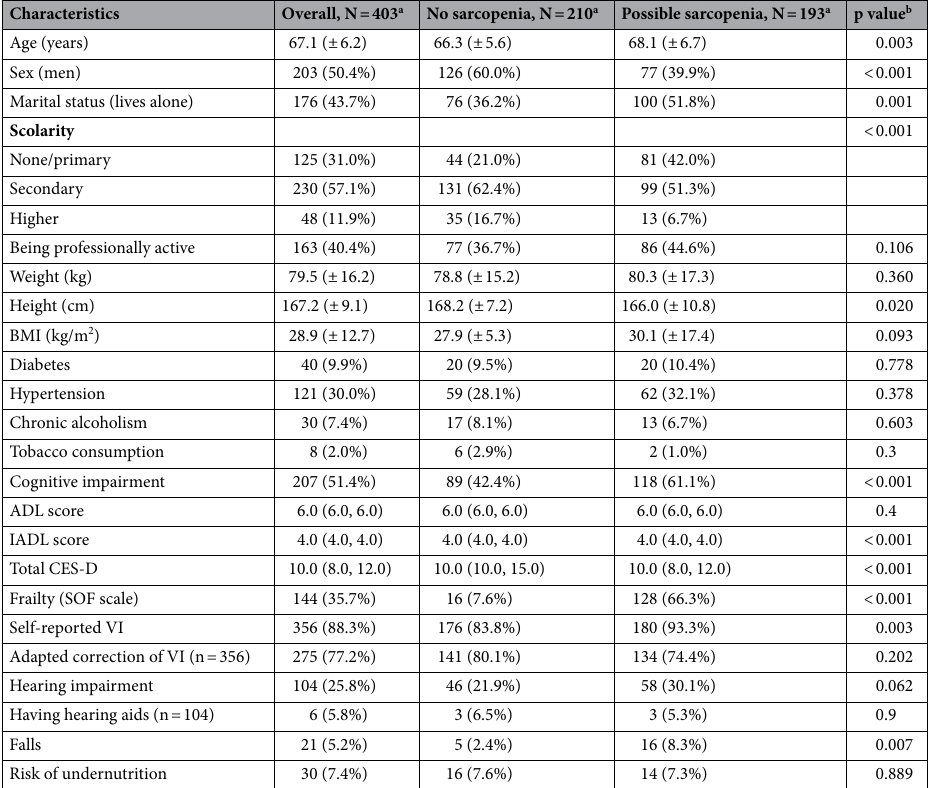
Table 1. Sociodemographic and clinical characteristics of participants according to sarcopenia, Douala– Cameroon, 2019. BMI body mass index, ADL activities of daily living, IADL instrumental activities of daily living; SPPB short physical performance battery, CES-D Center for Epidemiologic Studies- Depression, SOF study of osteoporotic fractures. a n (%); mean (± SD); median (IQR: Q1, Q3). b Pearson’s Chi-squared test; t-Student test; Fisher’s exact test; Wilcoxon rank sum